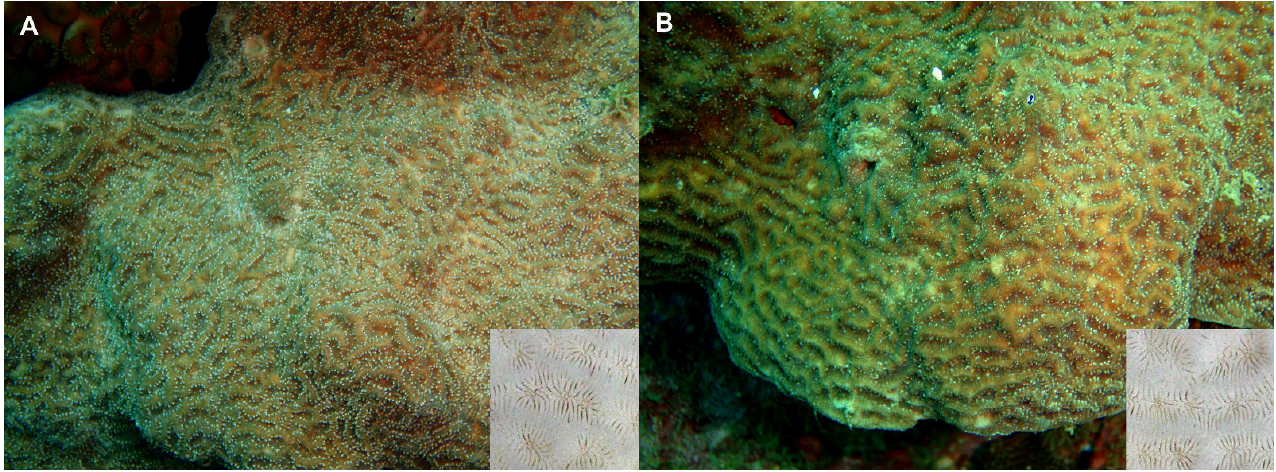
Figure 2. Photographs of two colonies of Psammocora columna Dana, 1846 collected by scuba diving on coral reefs in northern Taiwan and examined for coral-associated copepods in this study. ( A ) A colony of P . columna collected at 5 m depth at Longdon; ( B ) a colony of P . columna obtained at 9 m depth at Yanliao. The inserted photos show skeleton structure of each coral colony.